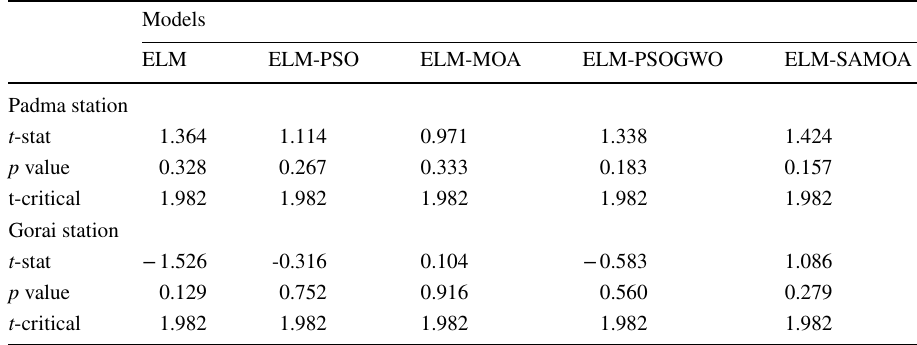
Table 6 The results of the single-phase, two-phase optimized and standalone ELM models in estimation of Gorai’s streamflow using data of Padma Station (Upstream)